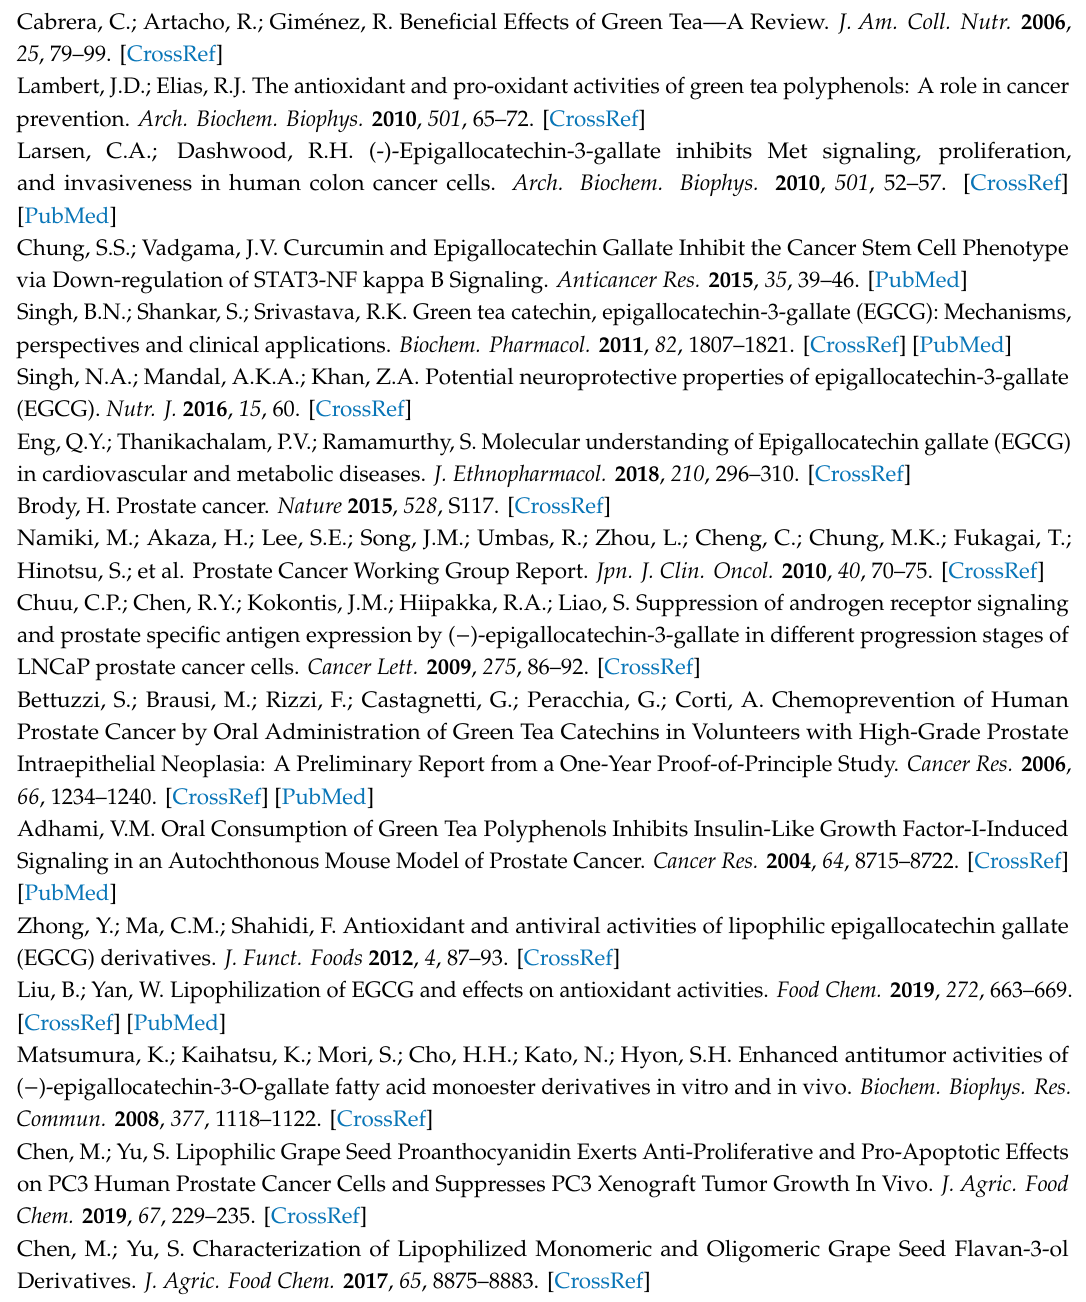
Table S1: 1 H and 13 C Chemical Shifts ( δ ) of EGCG and Tetralauroyl EGCG. Figure S1: The proposed signaling pathway triggered by LEGCG on DU145